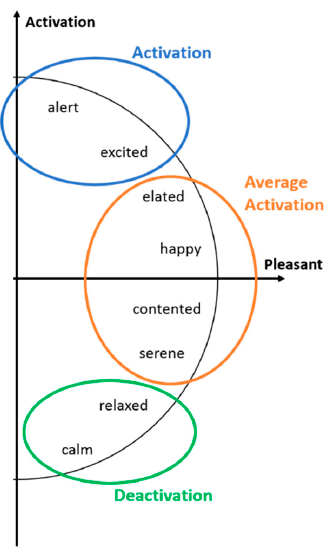
Figure 3. The position on the Russell’s model of the three classes of involvement considered: deactivation, average activation, and activation.